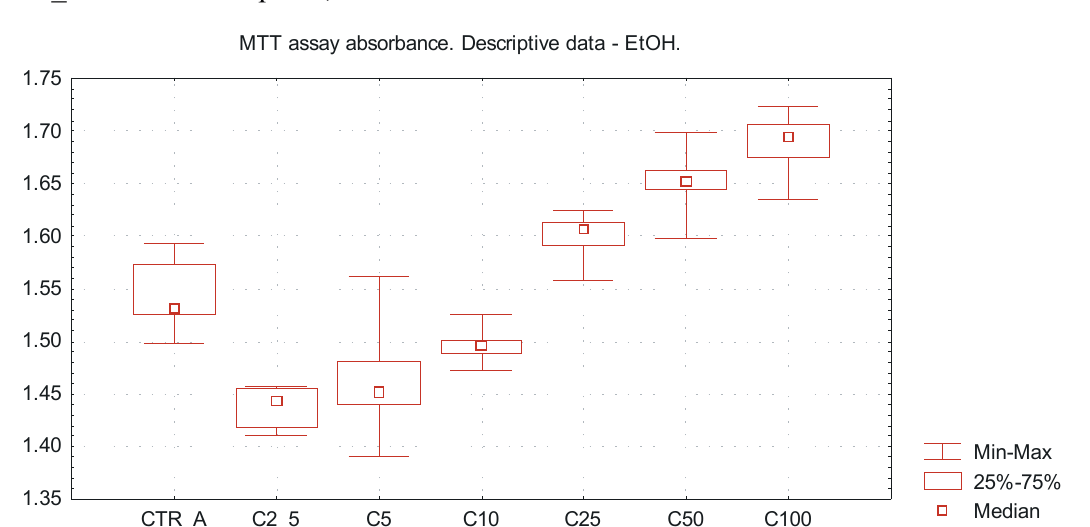
Figure 2. Viability of oral squamous cell carcinoma cells using MTT cytotoxicity assay, exposed to EtOH alone. Descriptive statistics of MTT cytotoxicity assay for EtOH exposure. The “U-shape” trends representing values of MTT absorbance for increasing EtOH concentrations ranged from 2.5 up to 100 mmol/L. Ultra low ethanol concentrations between 2.5 and 10 mmol/L reveal a slight inhibitory effect towards SCC-25 line cells, whereas investigated higher concentrations of ethanol (25–100 mmol/L) promote viability of SCC-25 cells, reflected by pro-proliferative action. X axis—EtOH concentrations [C]; CTR_A—control sample A; Y axis—absorbance values.